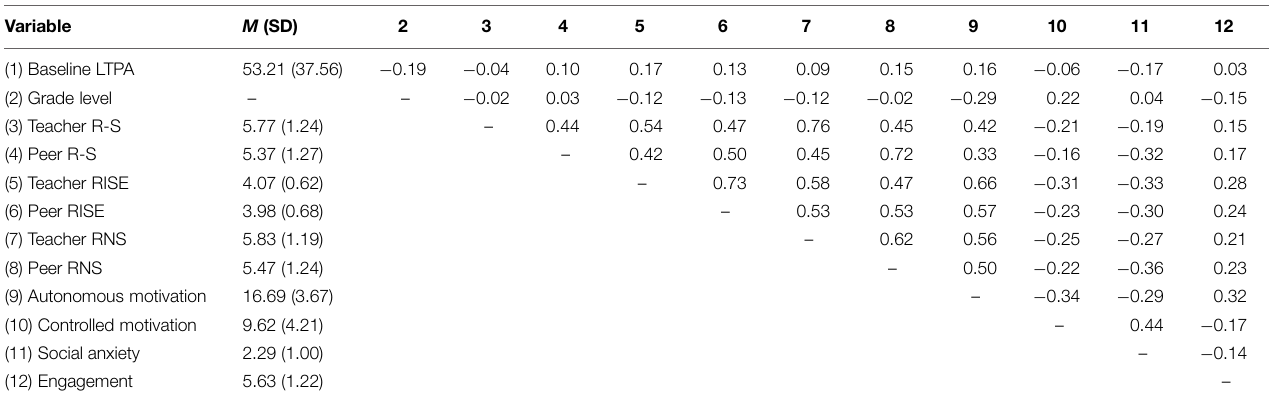
TABLE 1 | Aggregate-level descriptive data and correlations for all